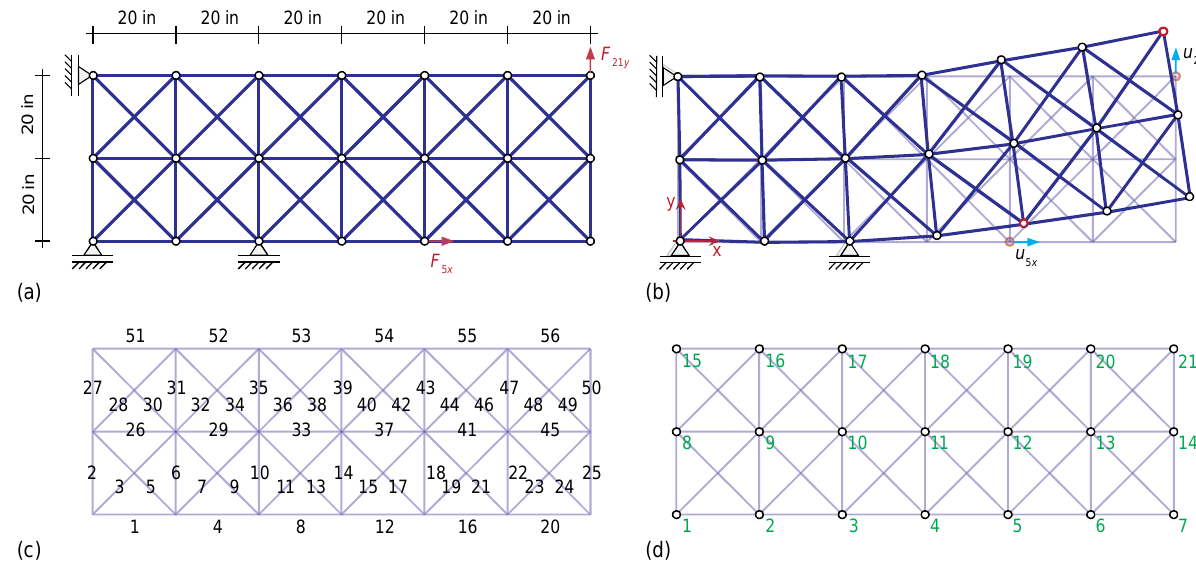
Figure 12. Truss cantilever structure: ( a ) dimension, loading, and boundary conditions, ( b ) deformed shape and displacements of interest, ( c ) truss member numbers, and ( d ) node numbers. Table 13. Description of the random variables for the cantilever truss optimization problem.